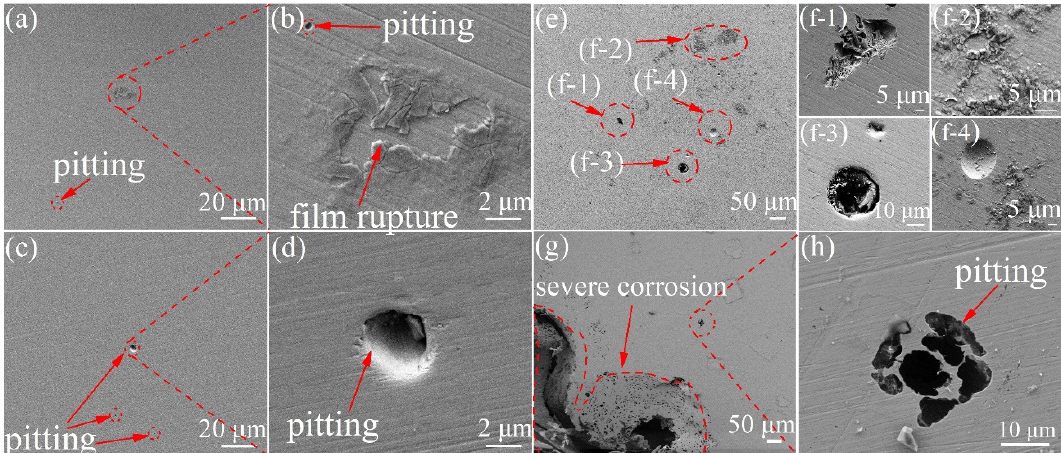
Figure 3. SEM micrographs of the electrochemical corroded surfaces of the Fe 59 BMG ( a ), Fe 54 Co 5 BMG ( c ), Fe 54 Ni 5 BMG ( e ), and 316L ( g ), respectively, and ( b , d , f , h ) are corresponding partial enlarged views.